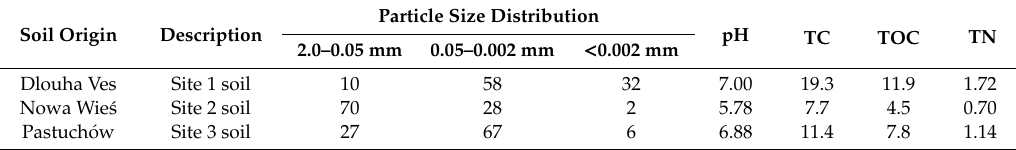
Table 1. Selected physical and chemical properties of the soil materials used in the experiment.